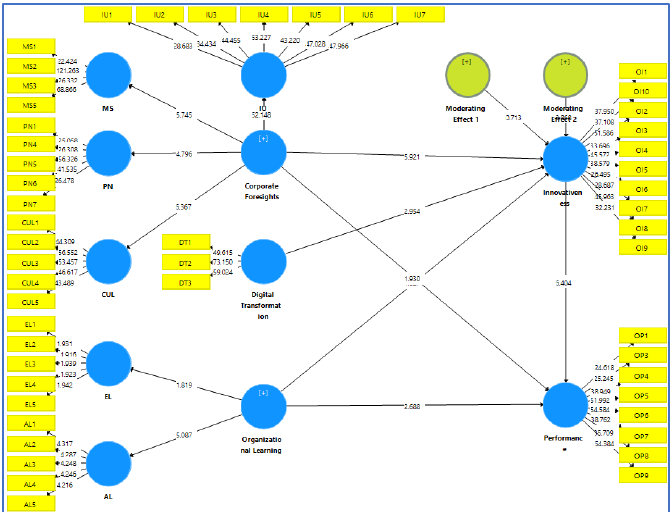
Fig. 2. Structural model